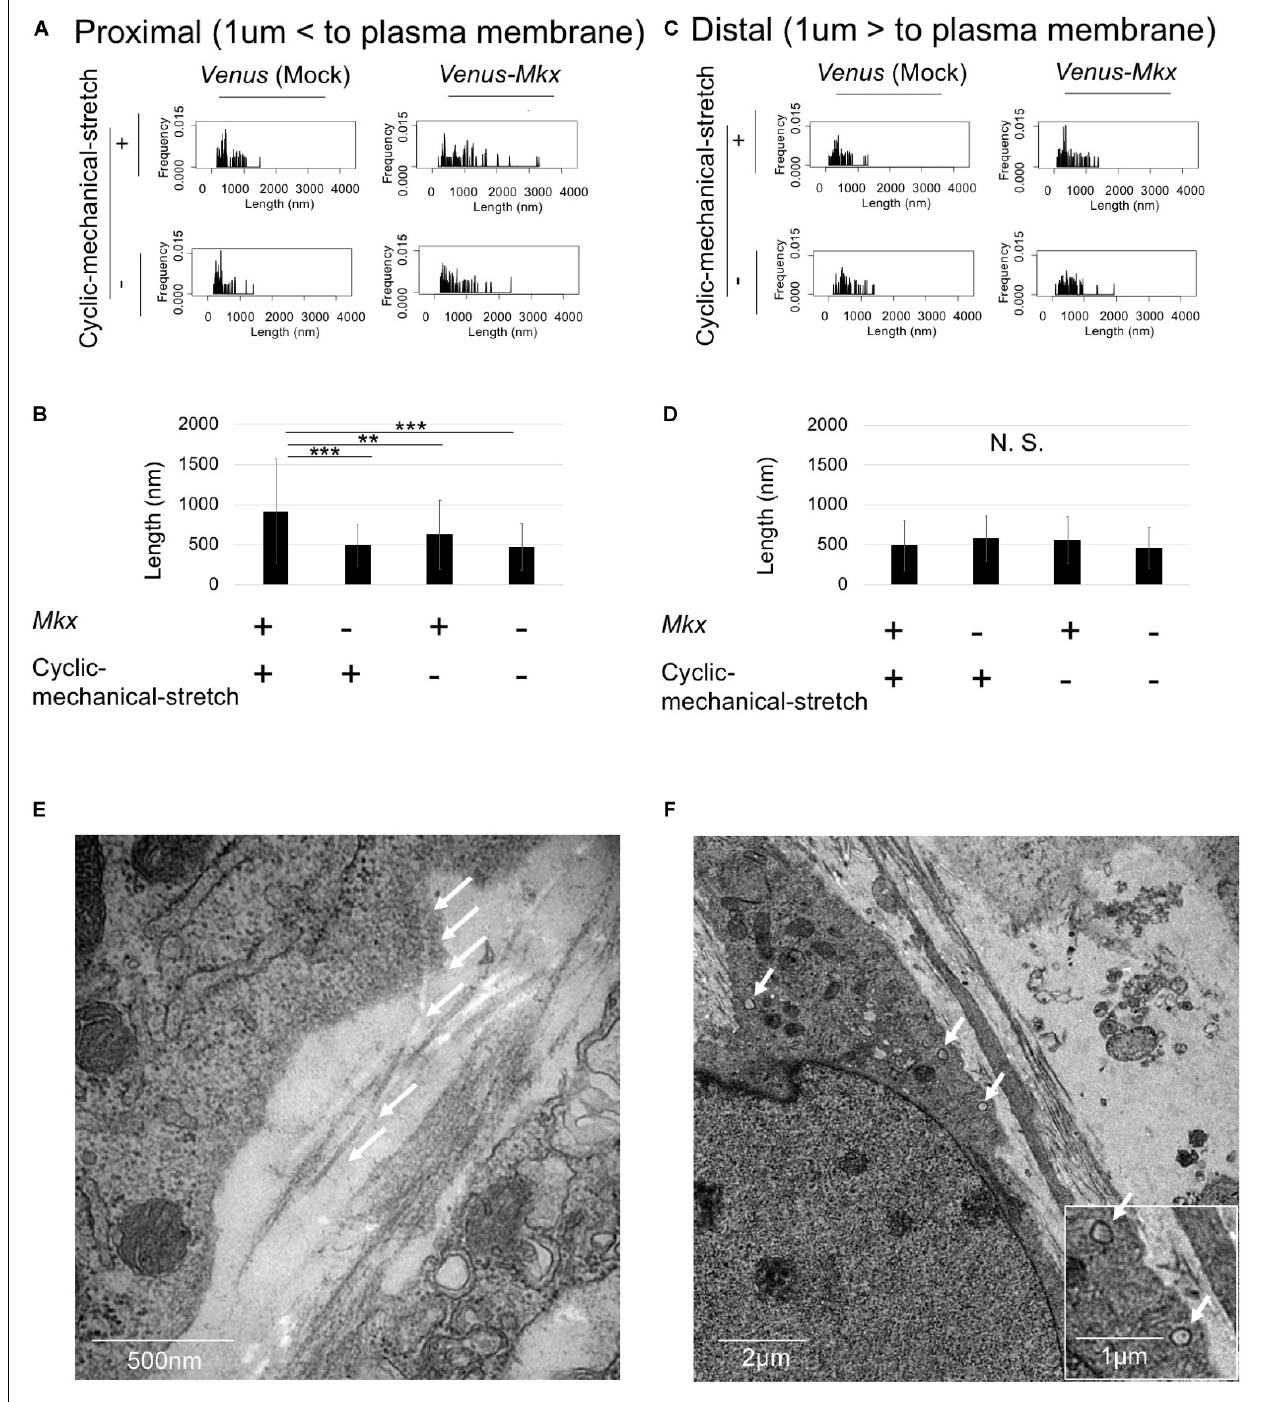
FIGURE 6 | Cells autonomously remodel the extracellular matrix during tendon/ligament-like tissue generation. (A–D) Analysis of collagen fibril length. These tissues were generated under four different culture conditions: VMS + (right top), VMS– (right bottom), VS + (left top), and VS– (left bottom) ( n = 2). The “cell proximal region” was defined as within 1 µ m of the plasma membrane, and the “cell distal region” as more than 1 µ m from the plasma membrane. The length of collagen fibril bundles in each region was measured. (A) Kernel Density Plots of collagen fibril length in the “cell proximal region.” Data were calculated from 60 collagen fibrils in three different fields of view. (B) Calculated mean collagen fibril length in the “cell proximal region” from each sample. The mean diameter of 60 collagen fibrils from